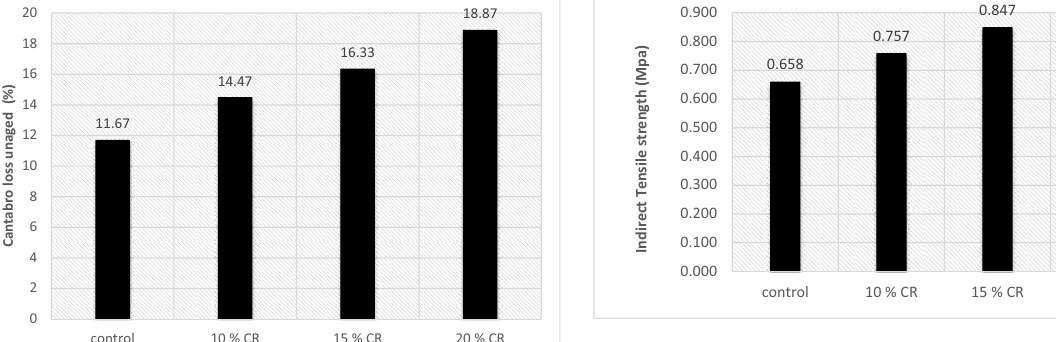
Figure 9: ITS results.